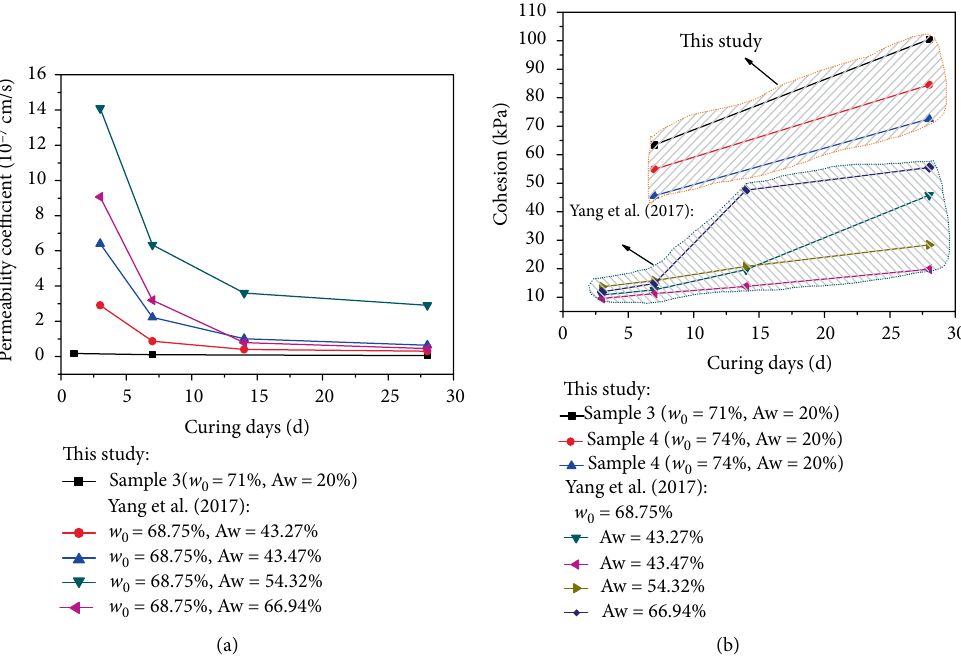
Figure 11: Comparison of geotechnical properties of solidified sludge with Yang et al. [10]: (a) permeability coefficient; (b)